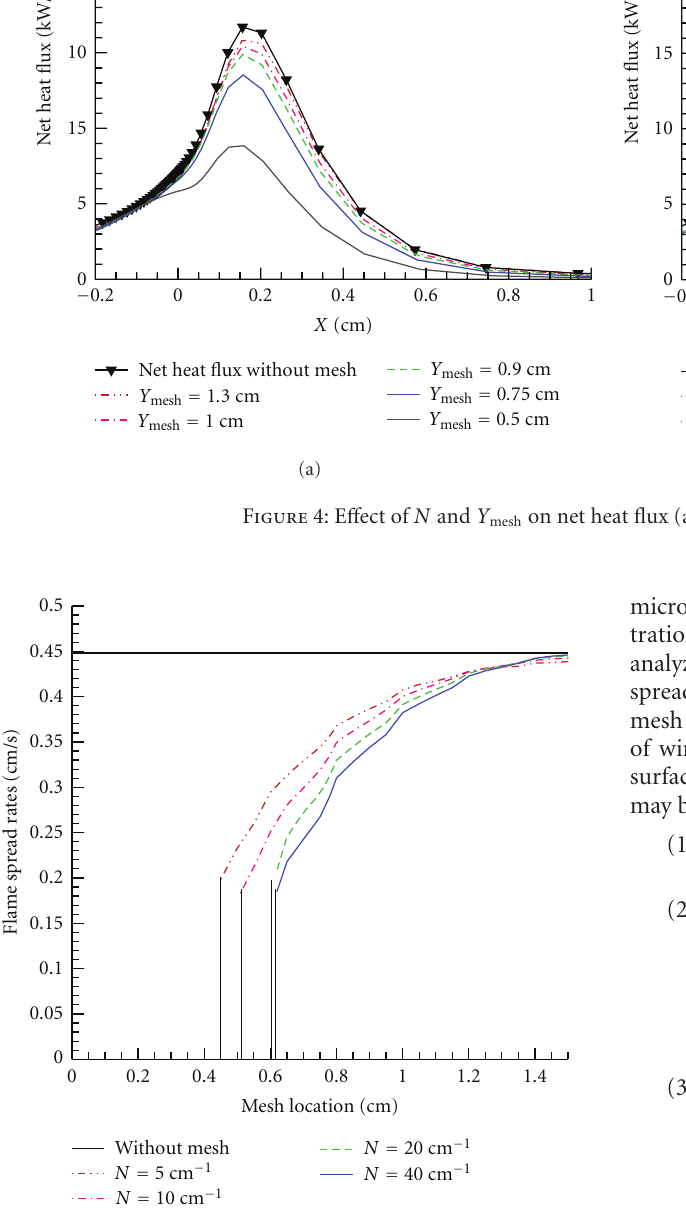
Figure 5: E ff ect of metallic wire mesh on flame spread